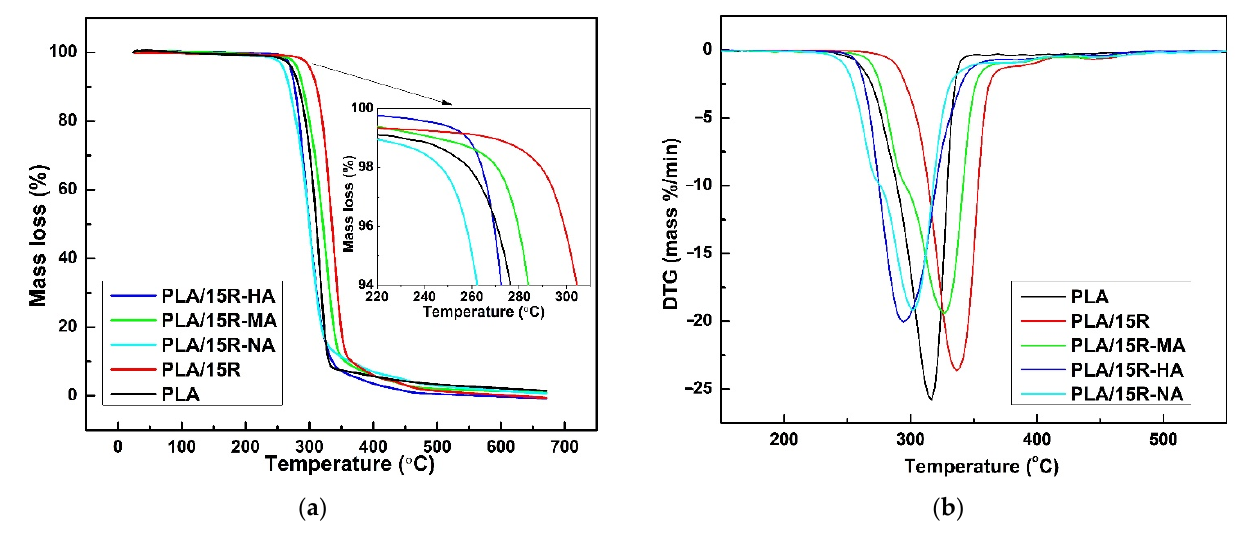
Figure 10. TG ( a ) and DTG ( b ) thermograms of neat PLA and PLA containing 15 wt% modified castor oil. castor oil. Table 4. Thermogravimetric data of neat PLA and PLA/R